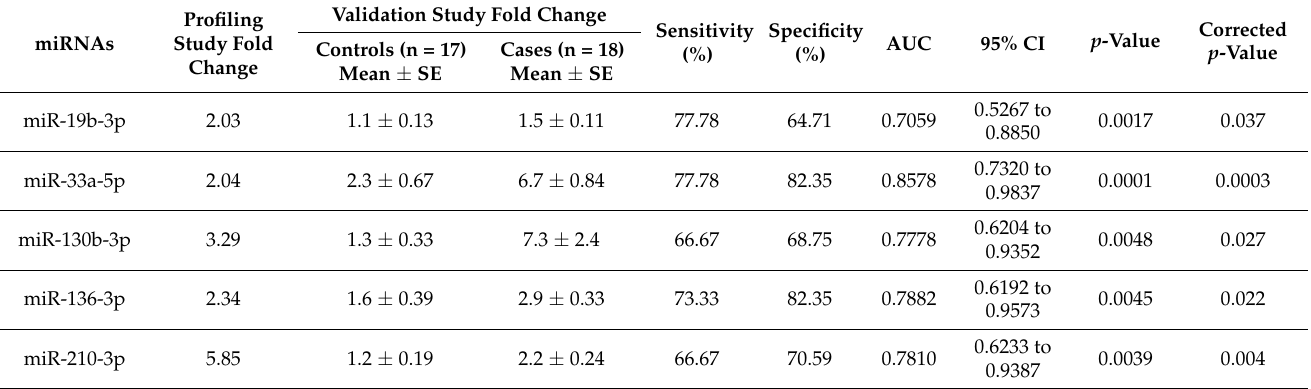
Table 1. ROC curve analysis for miRNAs with biomarker potential and their 95%